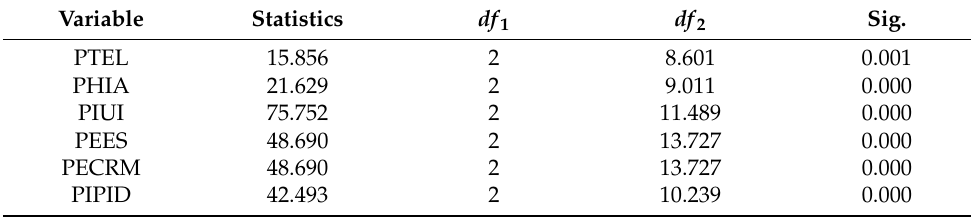
Table 5. Welch’s robust test of equality of means for 2012 clusters.